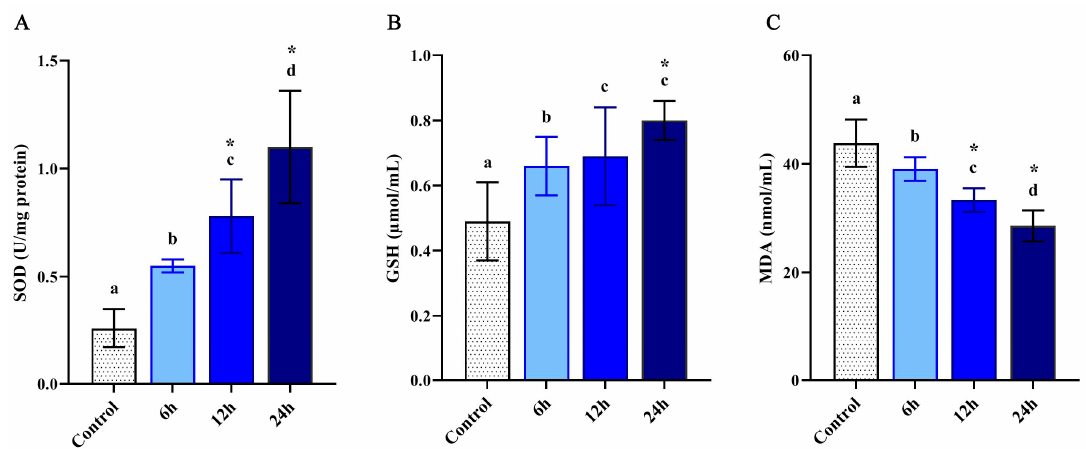
Figure 1. The activity of SOD ( A ), GSH ( B ) and MDA ( C ) of the control and injected M. domestica larval hemolymph at 6, 12 and 24 h post-injection with LPS. Different letters indicate significant difference ( p < 0.05). * indicate high significance with respect to control ( p < 0.01). Values were expressed as mean ± SD. The experiments were done in triplicate ( n = 3).